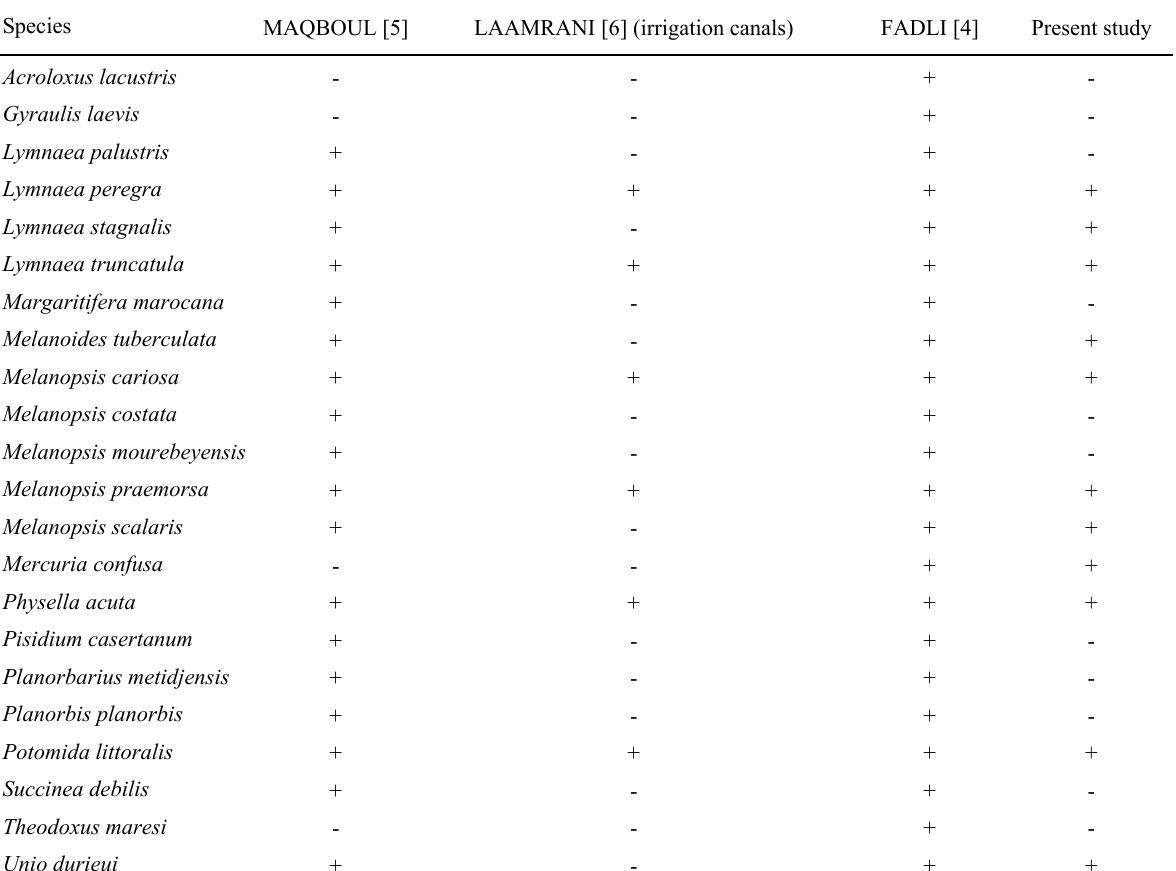
Table 2. Comparative table of the species currently present compared to those previously reported.